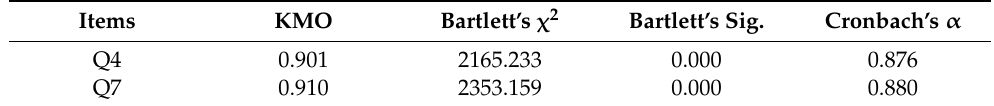
Table 2. Reliability analysis and validity analysis of Q4 and